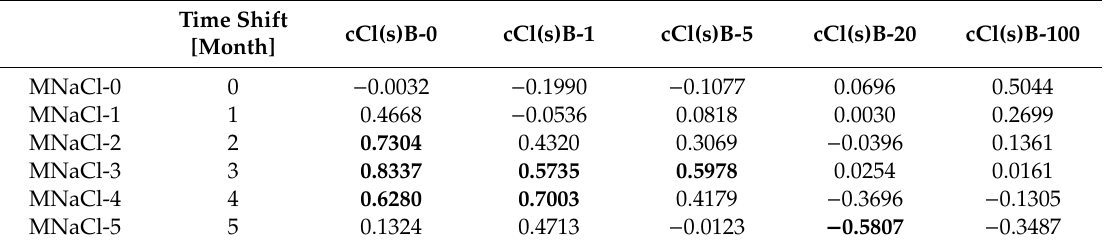
Table 8. Pearson correlation coe ffi cients between chloride concentrations in soils and the amount of applied de-icing salt—Site B. Sample size n =